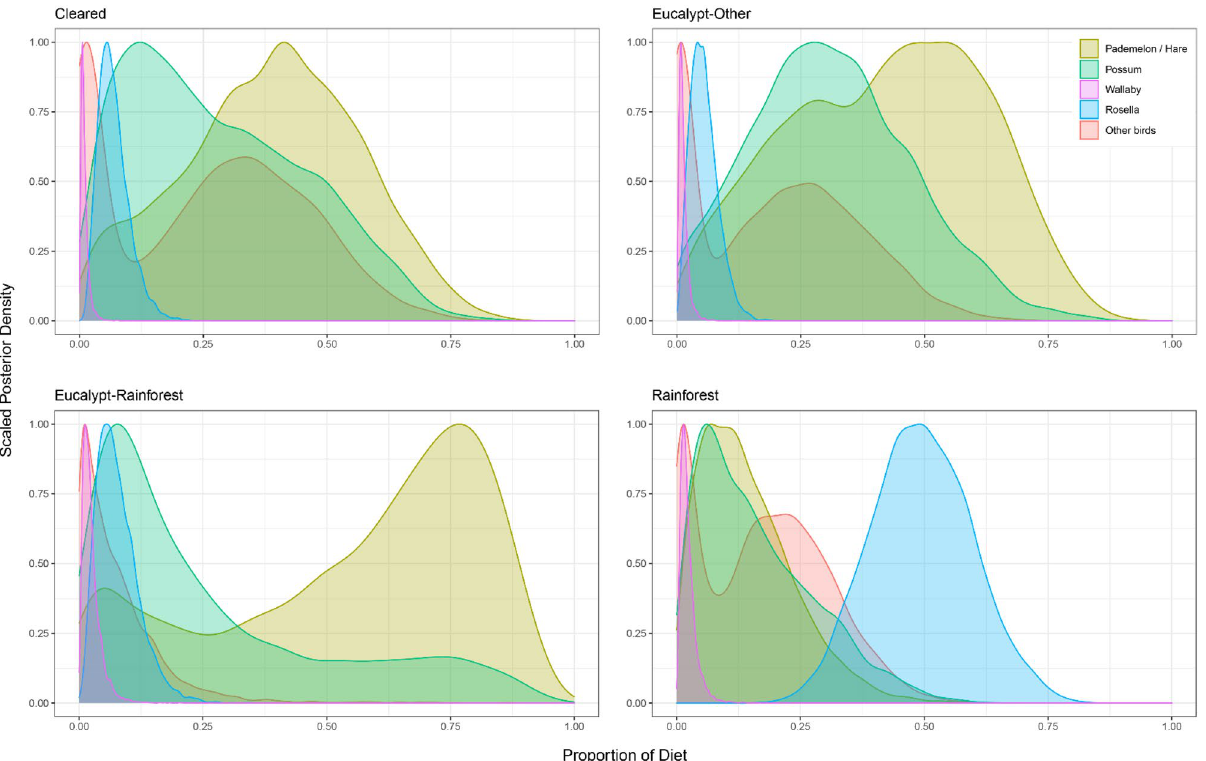
Figure 5. Posterior plot of the estimated diet composition of devils living in four habitats with differing anthropogenic impacts (cleared land, wet eucalypt-other, wet eucalypt-rainforest, rainforest). Five potential food groups were included in the mixing model based on Lewis et al. 54 : Tasmanian pademelon/European hare; brushtail possum; red-necked wallaby; green rosella; and other birds (black currawong; laughing kookaburra; and masked lapwing). Mean proportions, standard deviations and 95% CIs are included in